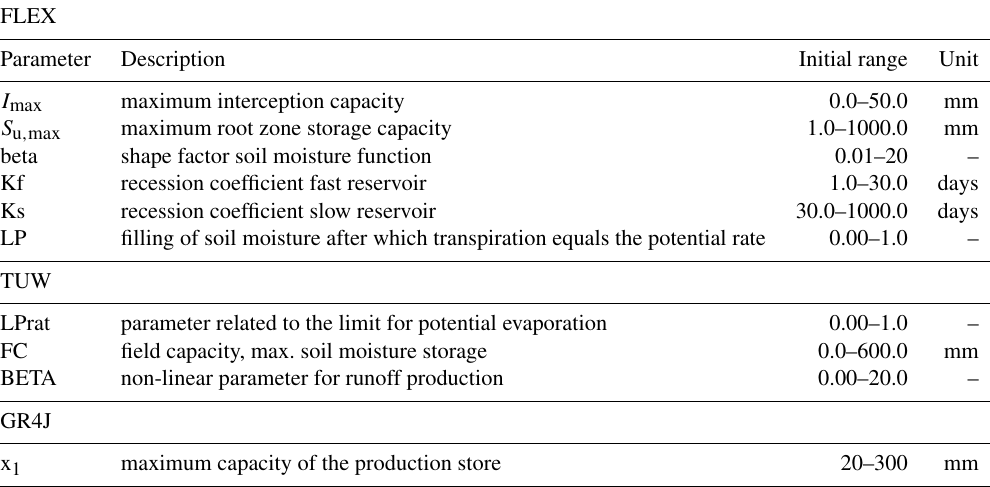
Table 3. Calibrated parameters related to vegetation (note: not all the calibrated parameters) in the FLEX, TUW, and GR4J model. See Supplement S6 for all calibrated model